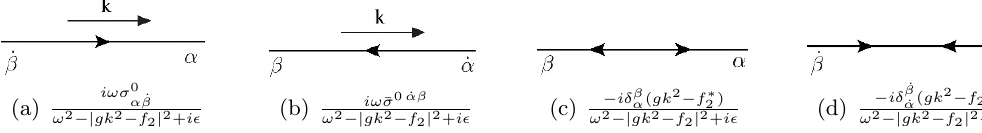
Figure 2 . Feynman diagram representation for the bosonic propagator, in correspondence with equation (3.54).